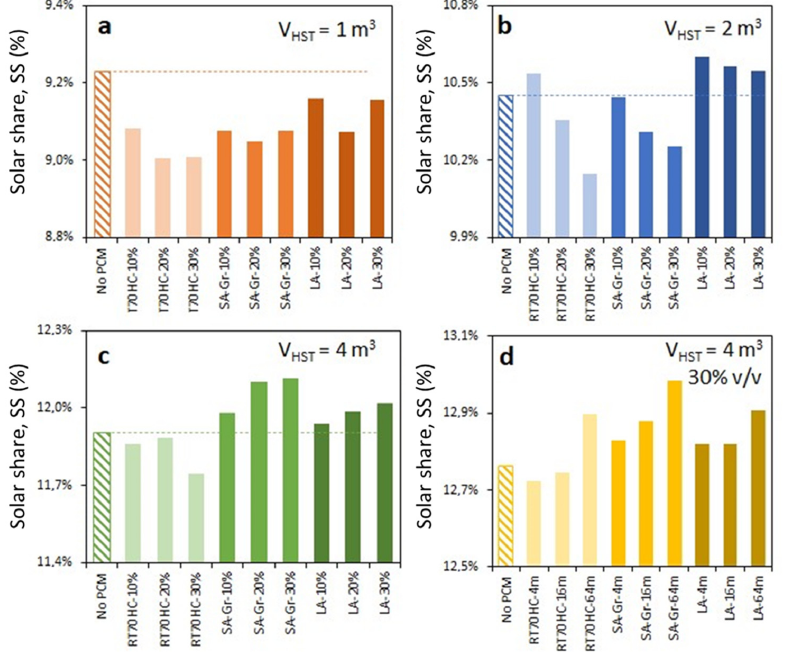
Figure 13. Role of the PCM type, HST volume, PCM volume fraction in the tank and number of PCM modules (heat exchange surface area) on the simulated annual solar share in the Spanish winery. Evaluation of the effect of PCM type and PCM volume fraction, keeping the aspect ratio of the HST constant, H HST /D HST = 1.75, and varying the tank volume: ( a ) V HST = 1 m 3 , ( b ) V HST = 2 m 3 , ( c ) V HST = 4 m 3 ; ( d ) role of exchange surface area for V HST = 4 m 3 , H HST = 1 m and 30% PCM volume fraction.